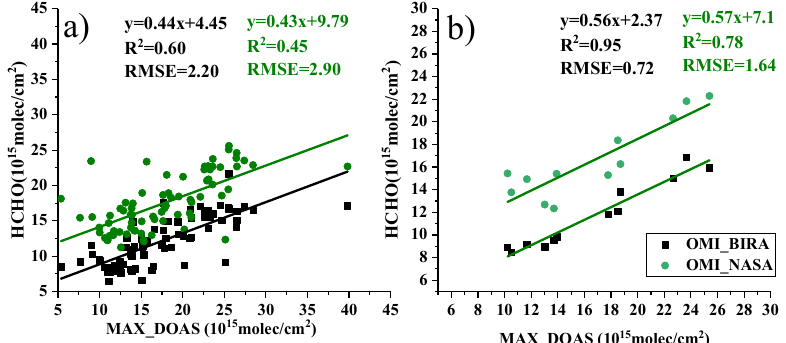
Figure 4. Monthly comparisons of OMI-BIRA and MAX-DOAS, and OMI-NASA and MAX-DOAS: ( a ) 2010–2016 monthly average; ( b ) 2010–2016 multi-year monthly average.